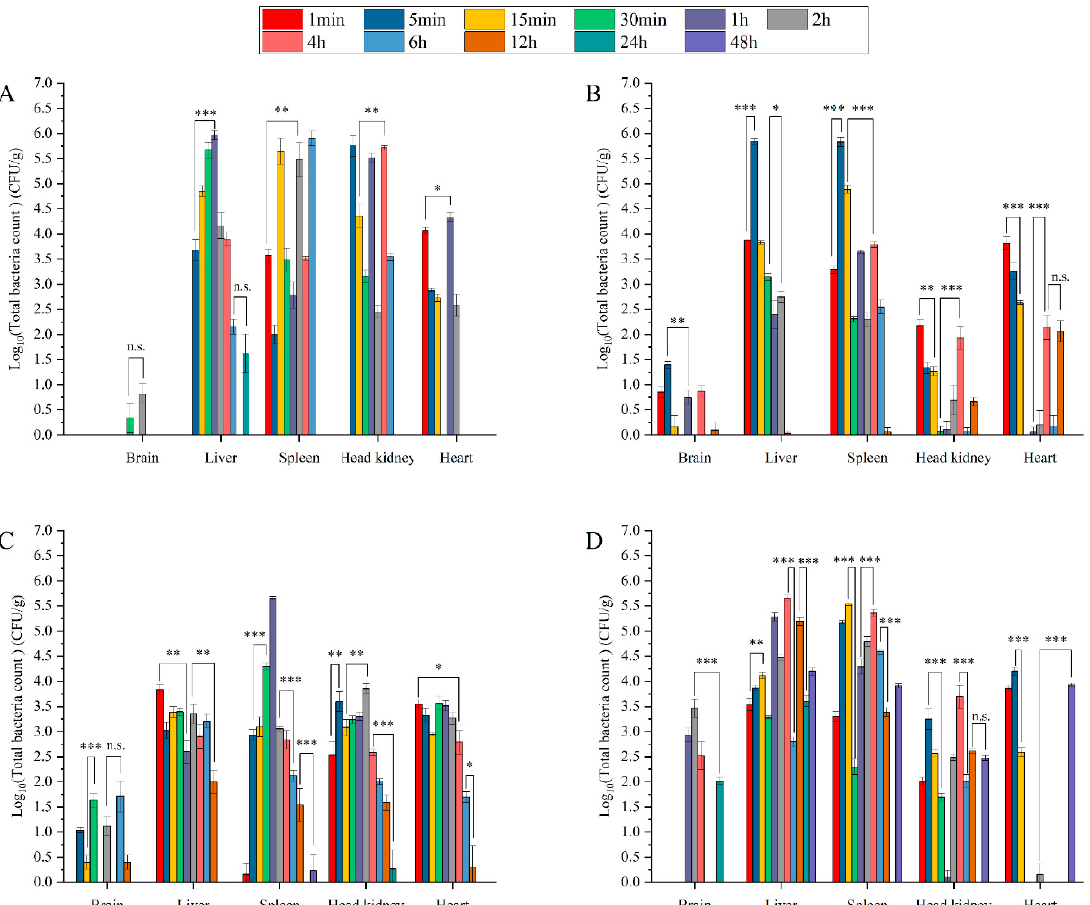
Figure 2. Spatiotemporal distribution of coinfected pathogens in brain, liver, spleen, head kidney and heart over 48 h postinjection. Data are shown as mean ± SD of three independent biological replicates. n.s., not significant; * p < 0.05, ** p < 0.01, *** p < 0.001. ( A – D ), Pathogen distribution of group A ( A ), group B ( B ), group C ( C ) and group D ( D ).